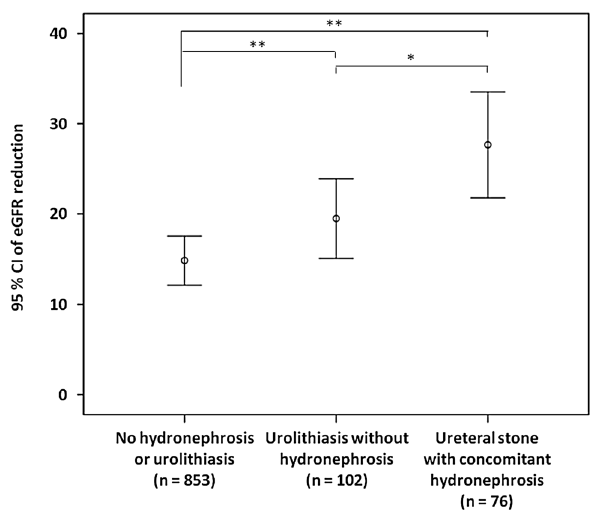
Figure 2. eGFR reduction in UTI patients with respect to ureteral stone with concomitant hydronephrosis and urolithiasis without hydronephrosis. eGFR estimated glomerular filtration rate, UTI urinary tract